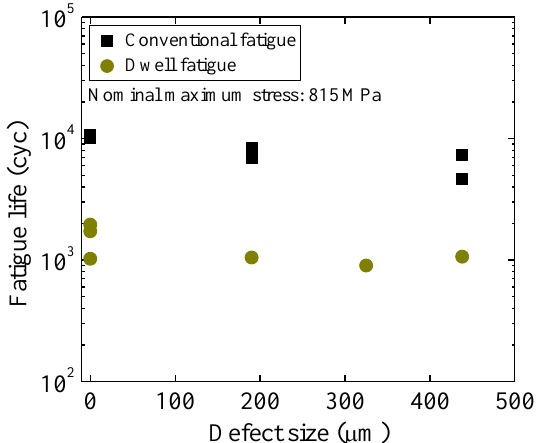
Figure 6. Comparison of fatigue performance between dwell fatigue test and conventional fatigue test for defective specimens.